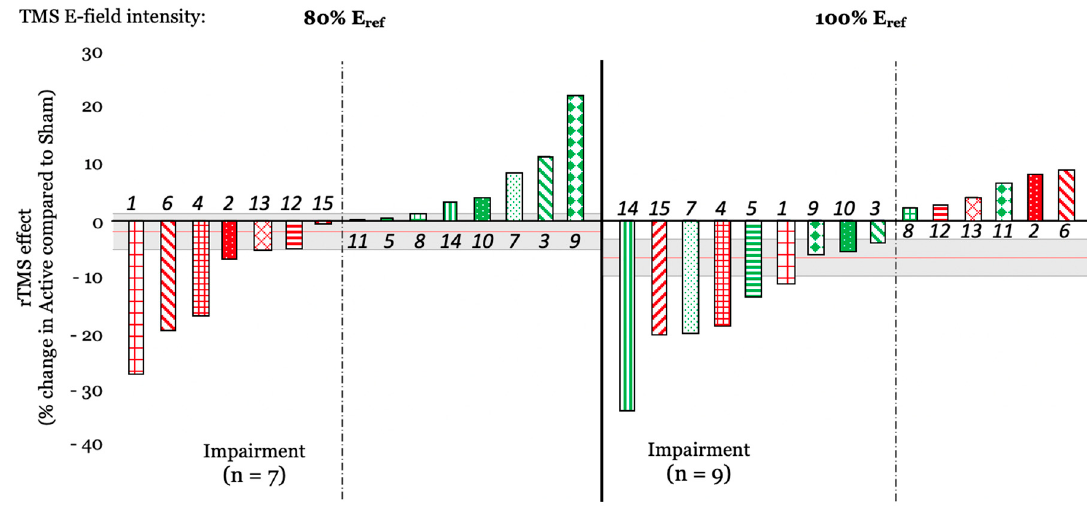
Figure 6. rTMS effect (expressed as a percentage of change between active and sham rTMS) for rTMS applied at 80% E ref (left) and at 100% E ref (right). Each bar is color-coded for each subject and based on rTMS effect at 80% Eref; numbers in italics represent the subject number. The red horizontal line shows the averaged rTMS effect across each subject (mean of − 2.03%, and − 6.66% for 80% E ref and 100% E ref , respectively). The gray rectangle represents the standard error (SE = 3.19% and 3.26% for 80% E ref and 100% E ref , respectively).